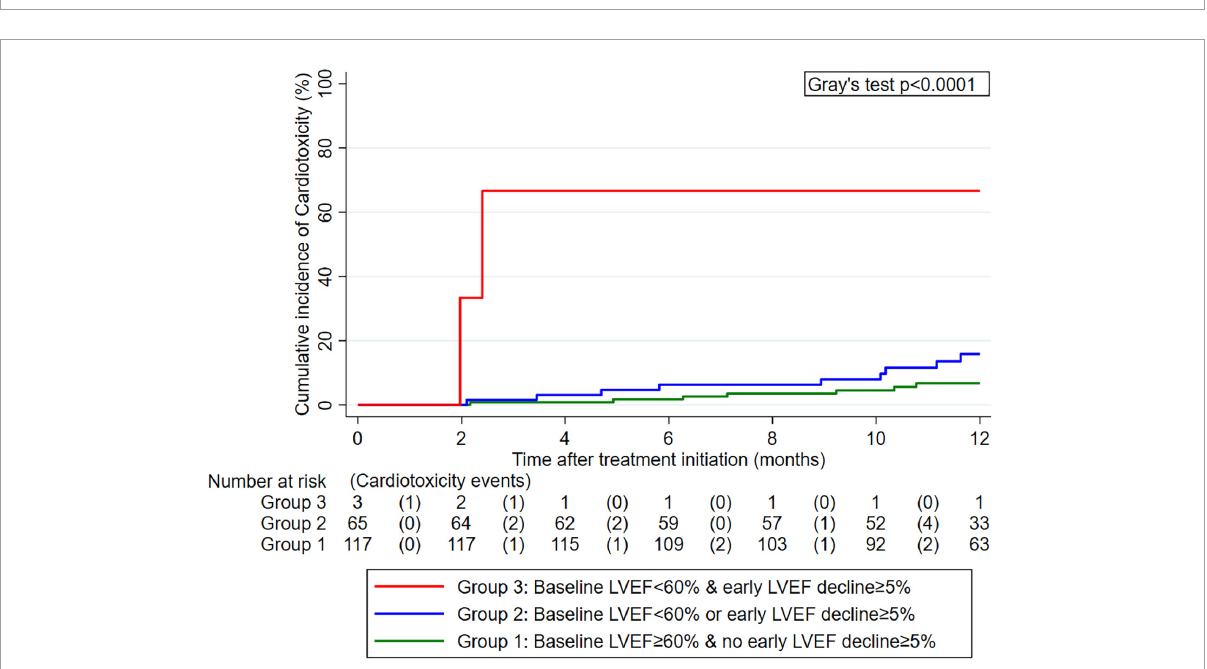
FIGURE4 Cumulative 12-month incidence of cardiotoxicity according to three groups defined by pre-treatment left ventricular ejection fraction (LVEF) and early LVEF change after treatment initiation ( n = 185). Data were estimated with competing risk cumulative incidence estimators, treating death-from-any-cause as the competing event of interest. The numbers below the x -axis represent a risk table with the number of patients at risk for cardiotoxicity at the beginning of each interval and the number of patients who developed cardiotoxicity during the pertinent interval in round